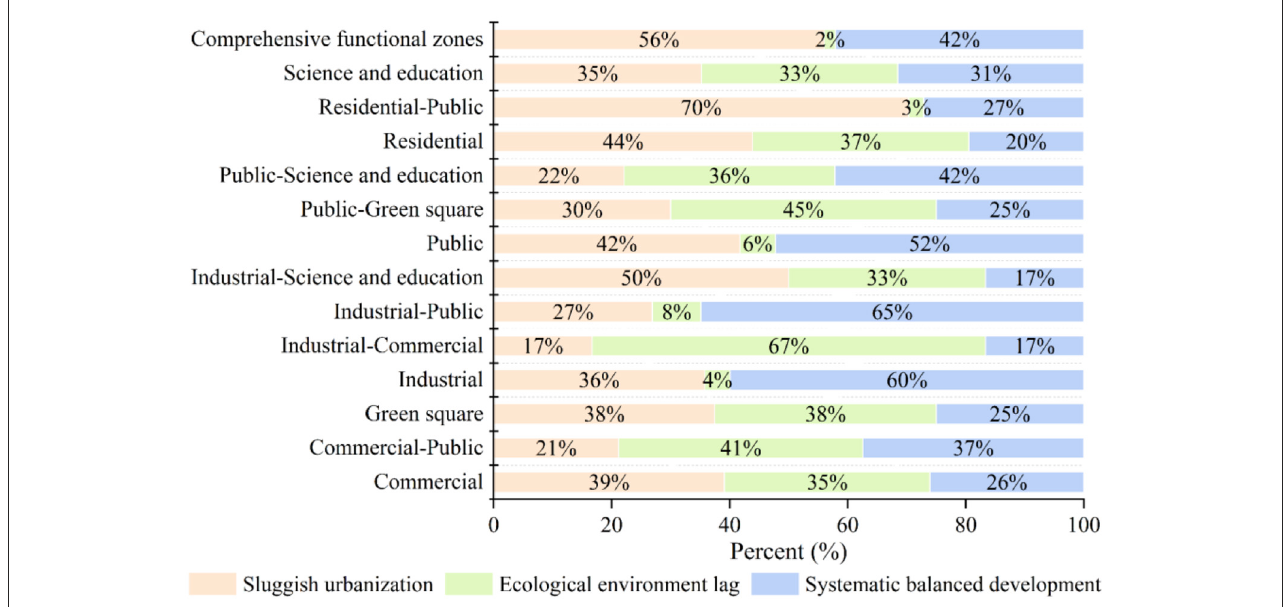
FIGURE6 Percentage of coupling coordination classifications in each urban functional zone.